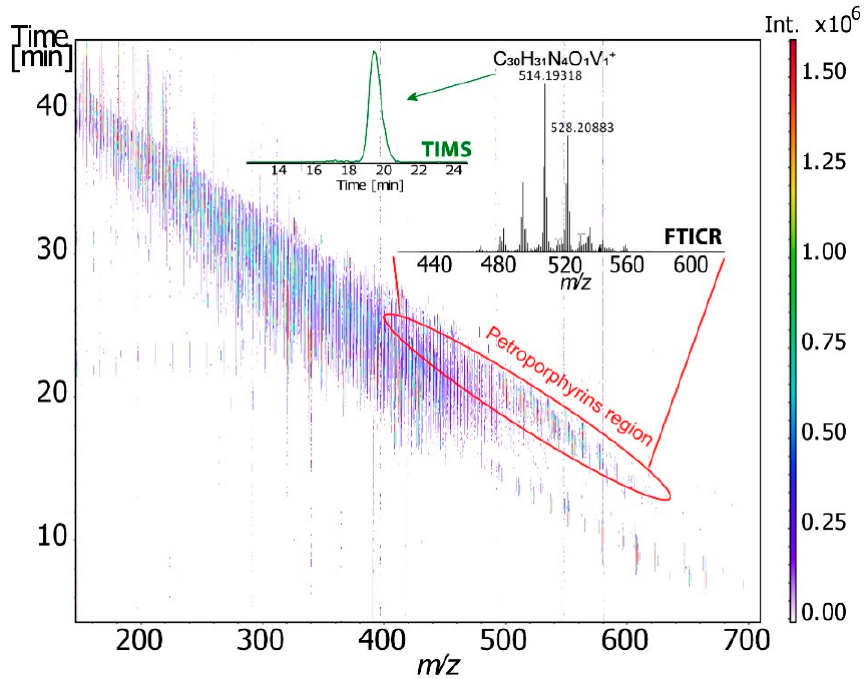
Figure 7. 2D TIMS-FT-ICR-MS survey spectra of the Athabasca asphalten. Reprinted with permission from Ref. [119]. 2021 , Carlos Afonso.